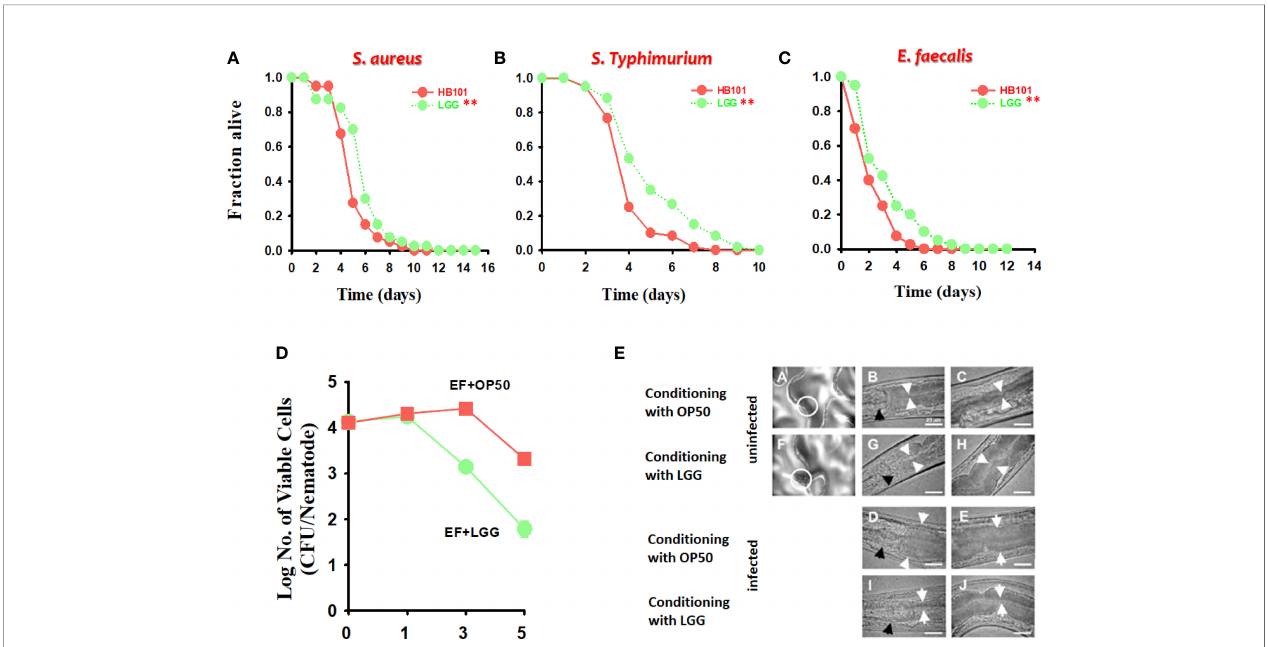
FIGURE 2 | The effect of preconditioned LGG on the survival of C. elegans infected with both gram-positive and gram-negative pathogens. C. elegans killing assays of strains fer-15;fem-1 infected with (A) S. aureus RN6390 or (B) S. Typhimurium SL1344 and fer-15;ferm-1 and glp-4 infected with (C) E. faecalis MMH594 after exposure to LGG for 24 h. The signi fi cance of differences between survival curves (Kaplan – Meier method) was determined using the log-rank test. * p < 0.05; ** p < 0.01. (D, E) Bacterial burden (CFU/nematode) of E. faecalis in fer-15;fem-1 nematodes after pre-exposure to OP50 or LGG. The white circle in A (exposed to OP50) and F (exposed to LGG) is the digestive tract and this area is for viewing at a higher magni fi cation. White arrows indicate the borders of the intestinal lumen, and black arrows indicate the grinder organ. Scale bar, 25 m